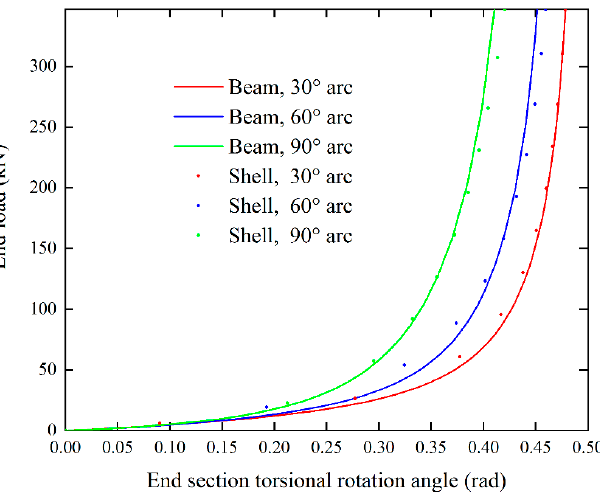
Figure 9. 3D structural configurations of a 30° pre-twisted cantilever with 90° arc profile cross sections and line load: ( a ) Present results; ( b ) ABAQUS results.